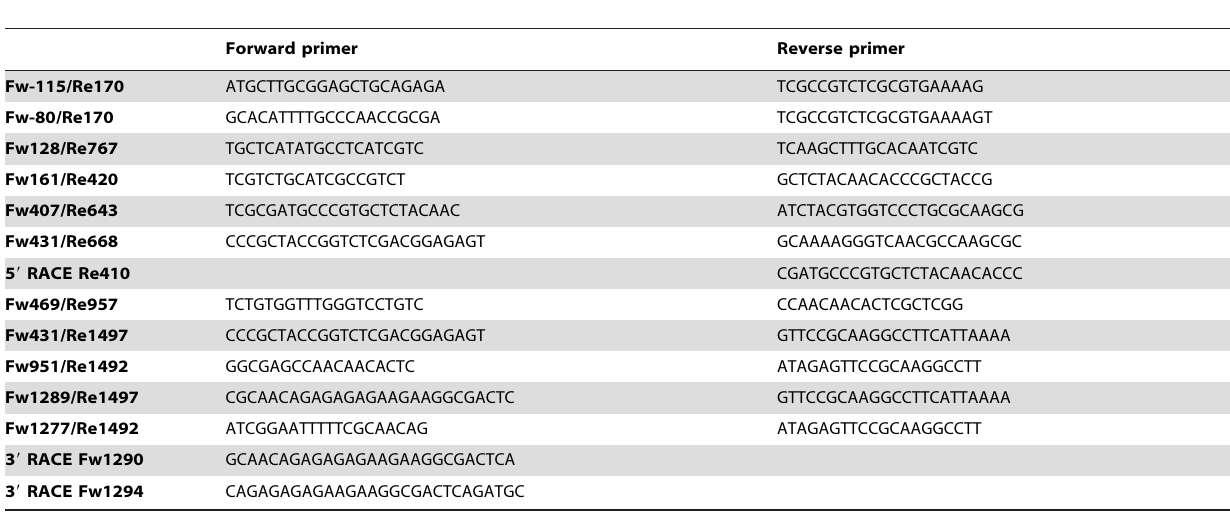
Table 1. Primers (5 9 to 3 9 ) used for the cloning of the lamprey dopamine D2 receptor gene.